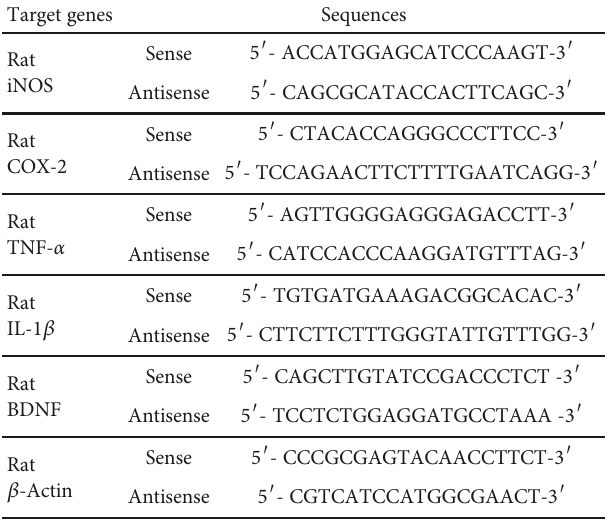
Table 1: Sequences of target gene-speci fi c primers used in real-time